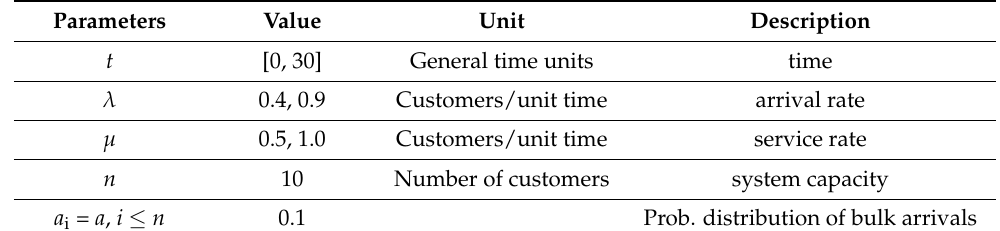
Table 1. Typical parameter configuration for numerical evaluation. Parameters Value Unit Description [0, 30] General time